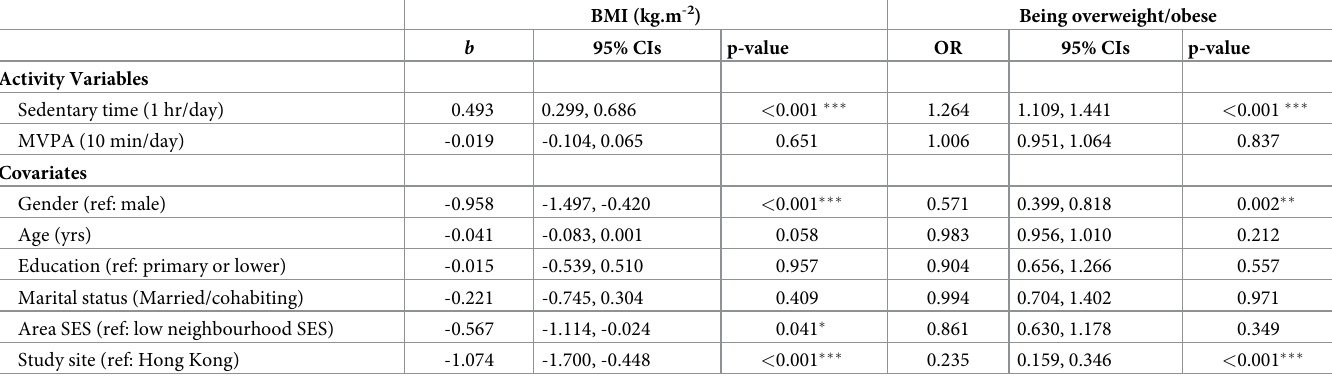
Moderating effects (2- and 3-way interactions) on associations of ST and MVPA with BMI and being overweight/obese (Table 3) Only a few significant moderators of ST or MVPA associations with BMI or being overweight/ obese were found. Study site moderated the interaction between ST and MVPA on both BMI and being overweight/obese. Specifically, a significant ST by MVPA interaction on BMI was found in Hong Kong only. In Hong Kong, the positive association between ST and BMI was Table 2. Associations of ST, MVPA and co-variates with BMI and being